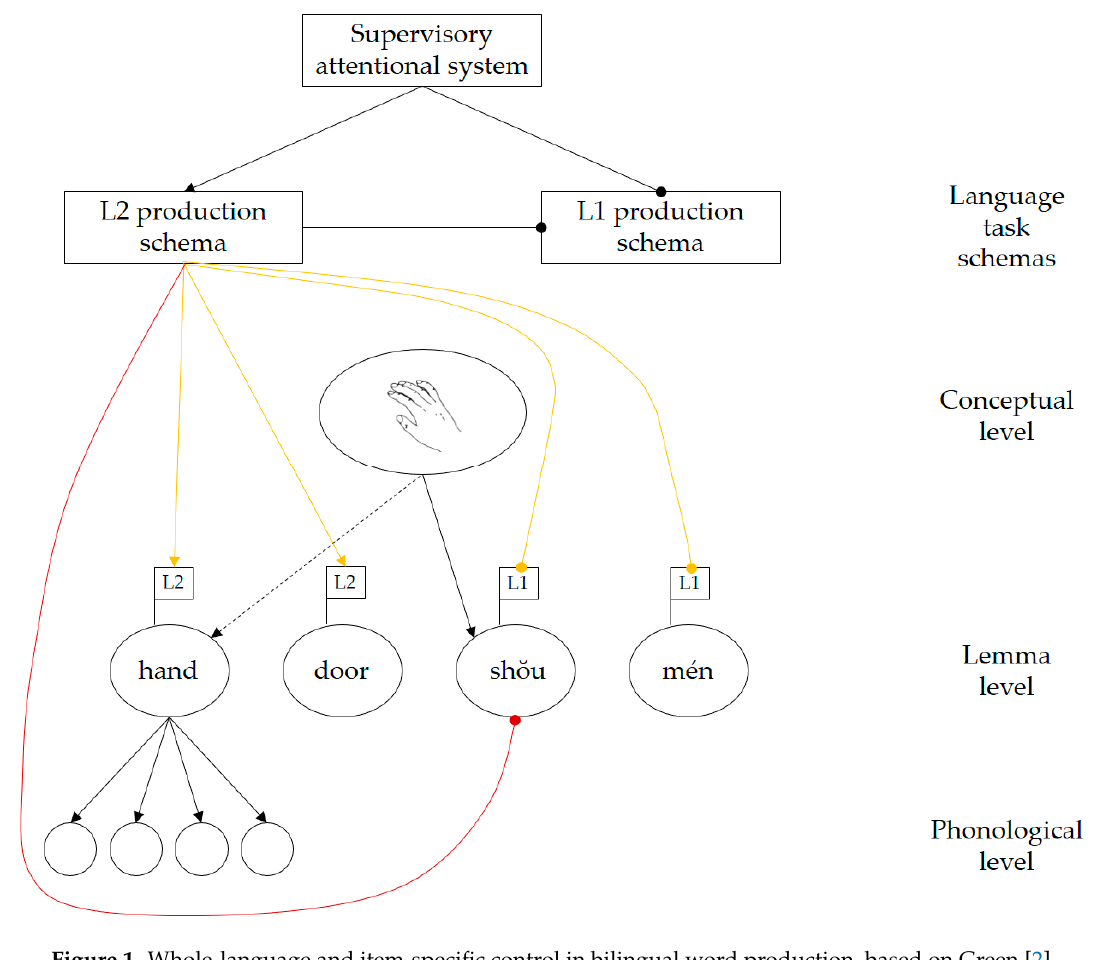
Figure 1. Whole-language and item-specific control in bilingual word production, based on Green [2] and De Groot and Christoffels [44]. Yellow lines indicate whole-language control; red lines indicate item-specific control. Arrow heads indicate excitation; circle heads indicate inhibition. In this example, the target language is L2 (English), and the non-target language is L1 (Mandarin). The intention to speak L2 is expressed by the supervisory attentional system, which activates the “L2 production schema” and suppresses the “L1 production schema”. The L2 production schema then applies whole-language control to regulate the activation levels of lemmas in the two languages, in order to bias selection towards L2 lemmas. The L1 lemma “sh˘ou” (translation-equivalent of the target name “hand”) receives strong activation from the concept and, thus, becomes a strong competitor despite being suppressed at the whole-language level. To ensure correct selection of the L2 lemma “hand” for output, the L2 production schema reactively inhibits “sh˘ou” to resolve the competition.